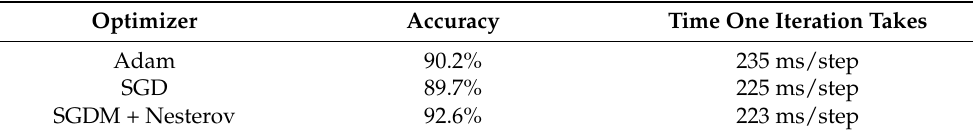
Table 2. Accuracy and time consumption of the optimizers Adam, SGD, and